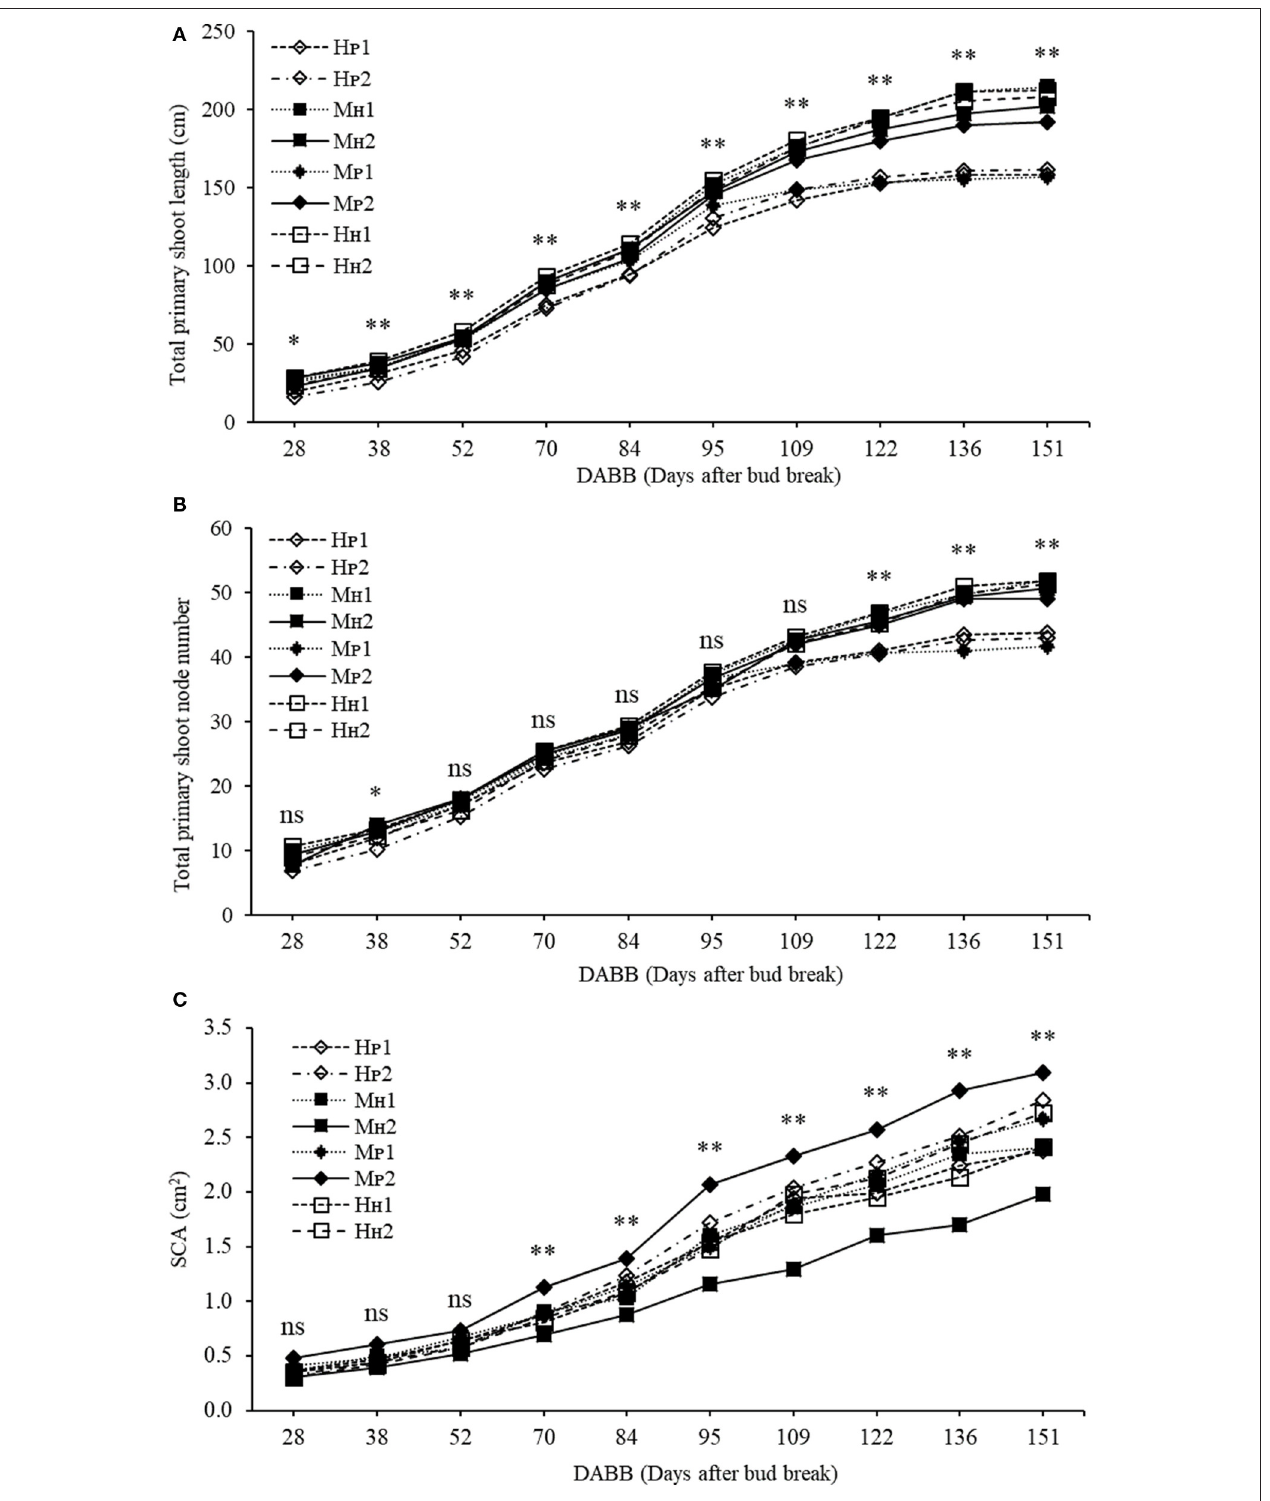
FIGURE 8 | Total primary shoot length (cm) (A) , total node number (B,C) scion cross-sectional area (cm 2 ) (SCA) of ‘PremP009’ and ‘Hosui’ considering genotype (‘PremP009’ and ‘Hosui’), type of grafting (homogenous and mixed) and shoot position (position 1 or 2). Each point represents the average of 6 replicates for homogenous and 3 for mixed trees. Asterisks indicate significant differences between treatments (* P < 0.05; ** P < 0.01). ns, not significant.